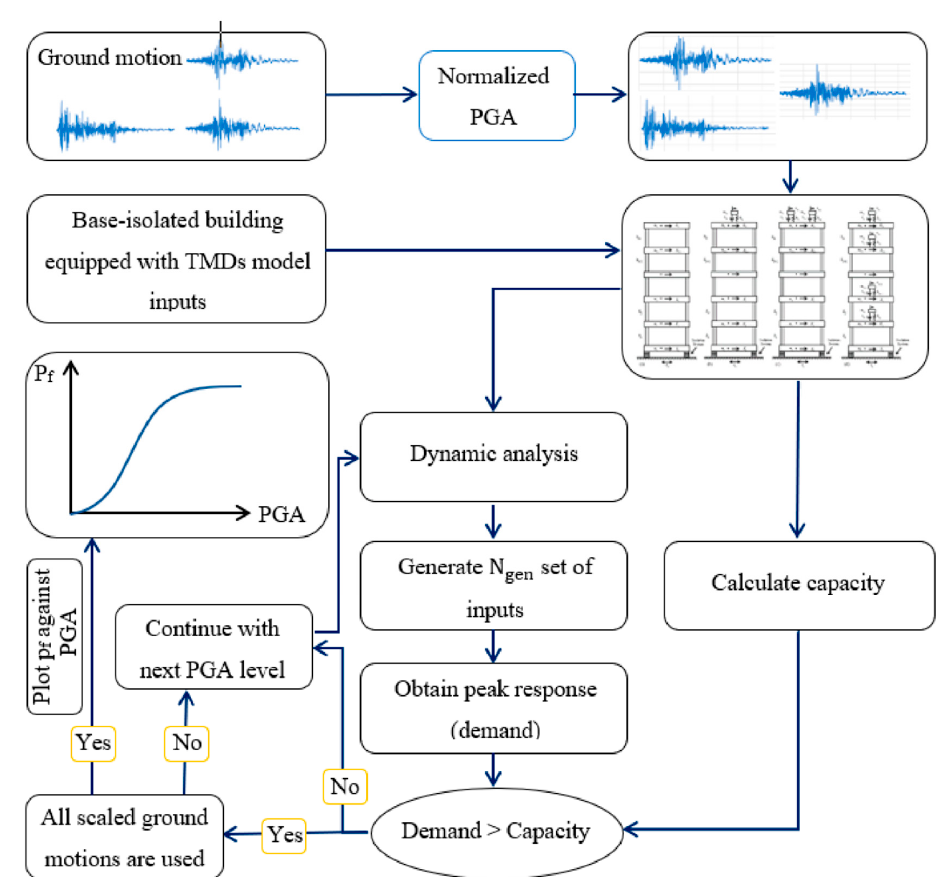
Appl. Sci. 2020 , 10 , x FOR PEER REVIEW Figure 9. Procedure for seismic fragility analysis of base-isolated building equipped with TMD schemes.